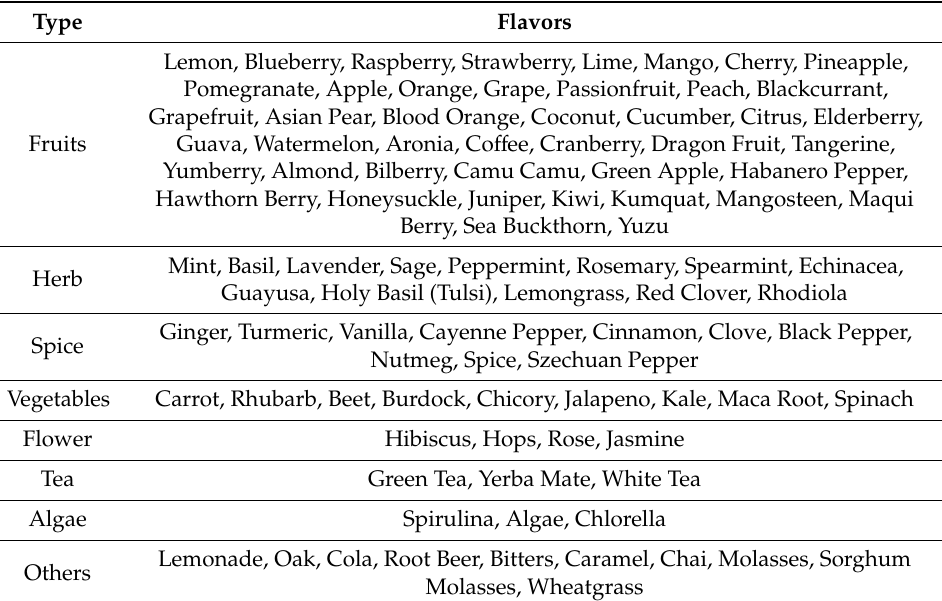
Table 5. Types and examples of flavoring of commercial kombucha